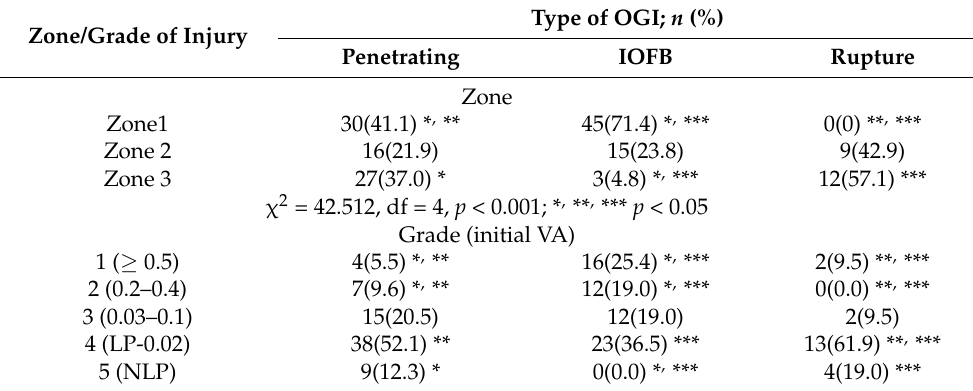
Table 2. Types of open globe injuries classified by zone and grade.